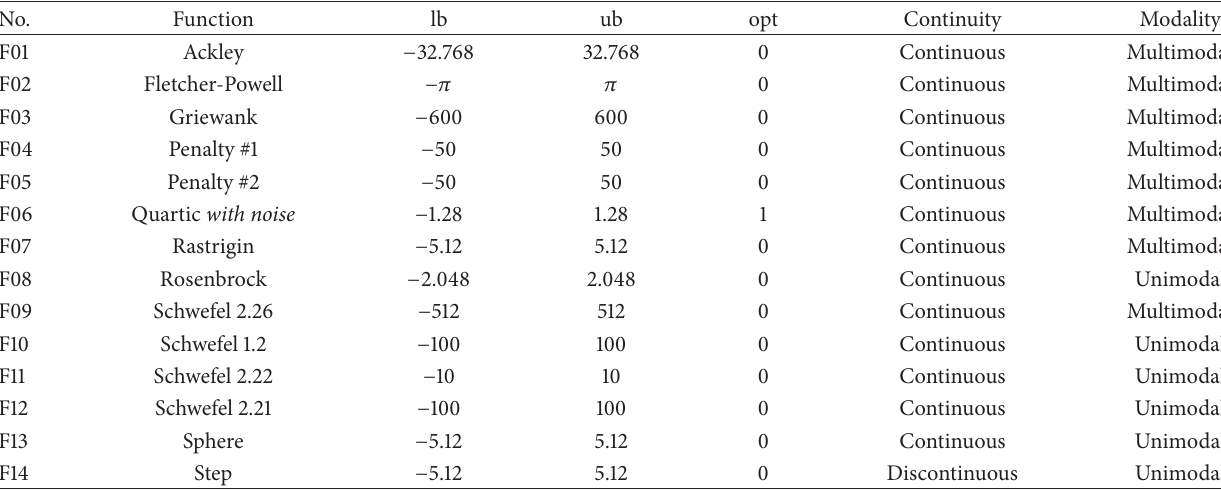
Table 2: Properties of benchmark functions; lb denotes lower bound, ub denotes upper bound, and opt denotes optimum point. No.